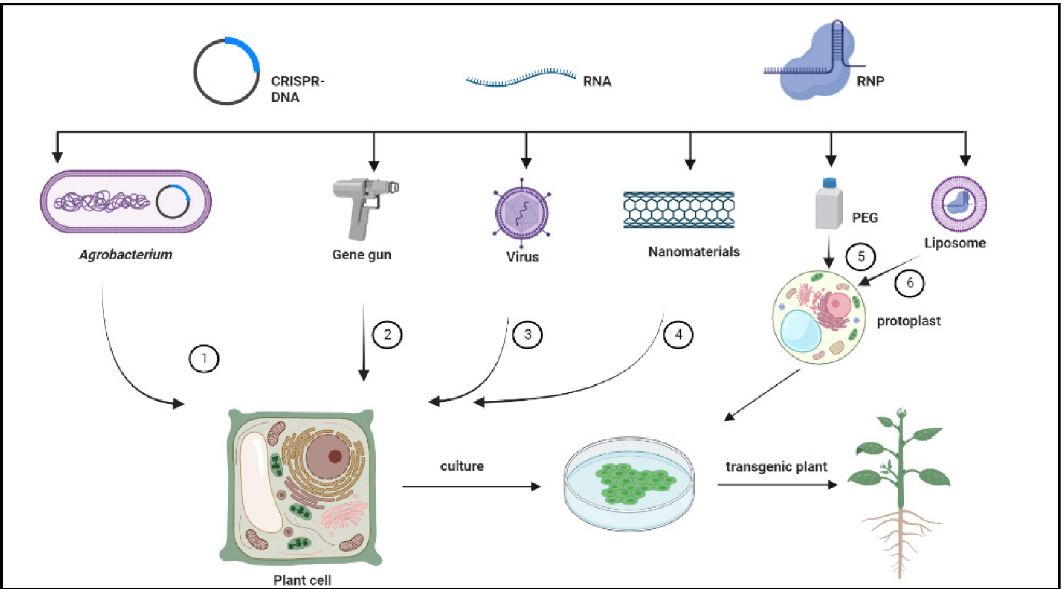
Figure 2. CRISPR/Cas system delivery technology, transferring foreign recombinant DNA by the CRISPR/Cas9. From the left side, (1) agrobacterium tumefaciens, (2) gene gun, (3) virus vector, (4) nanoparticles, (5) PEG, and (6) liposome carrying the targeted gene into the plant cell, which is further cultured (Provided by BioRender.com; accessed on 14 March 2022).